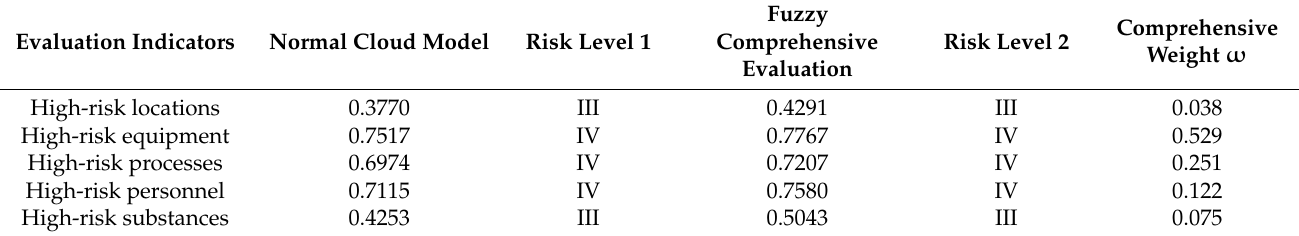
Table 10. Comparison of risk levels of LNG tank leakage accidents between two